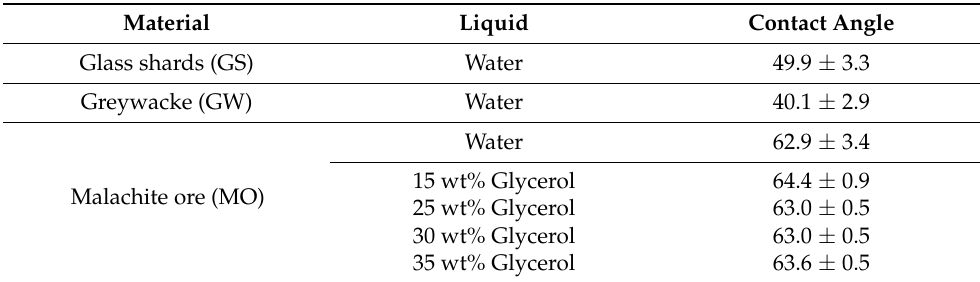
Table 3. Average contact angles obtained from wettability experiments conducted on three selected materials using different solutions at 30 ◦